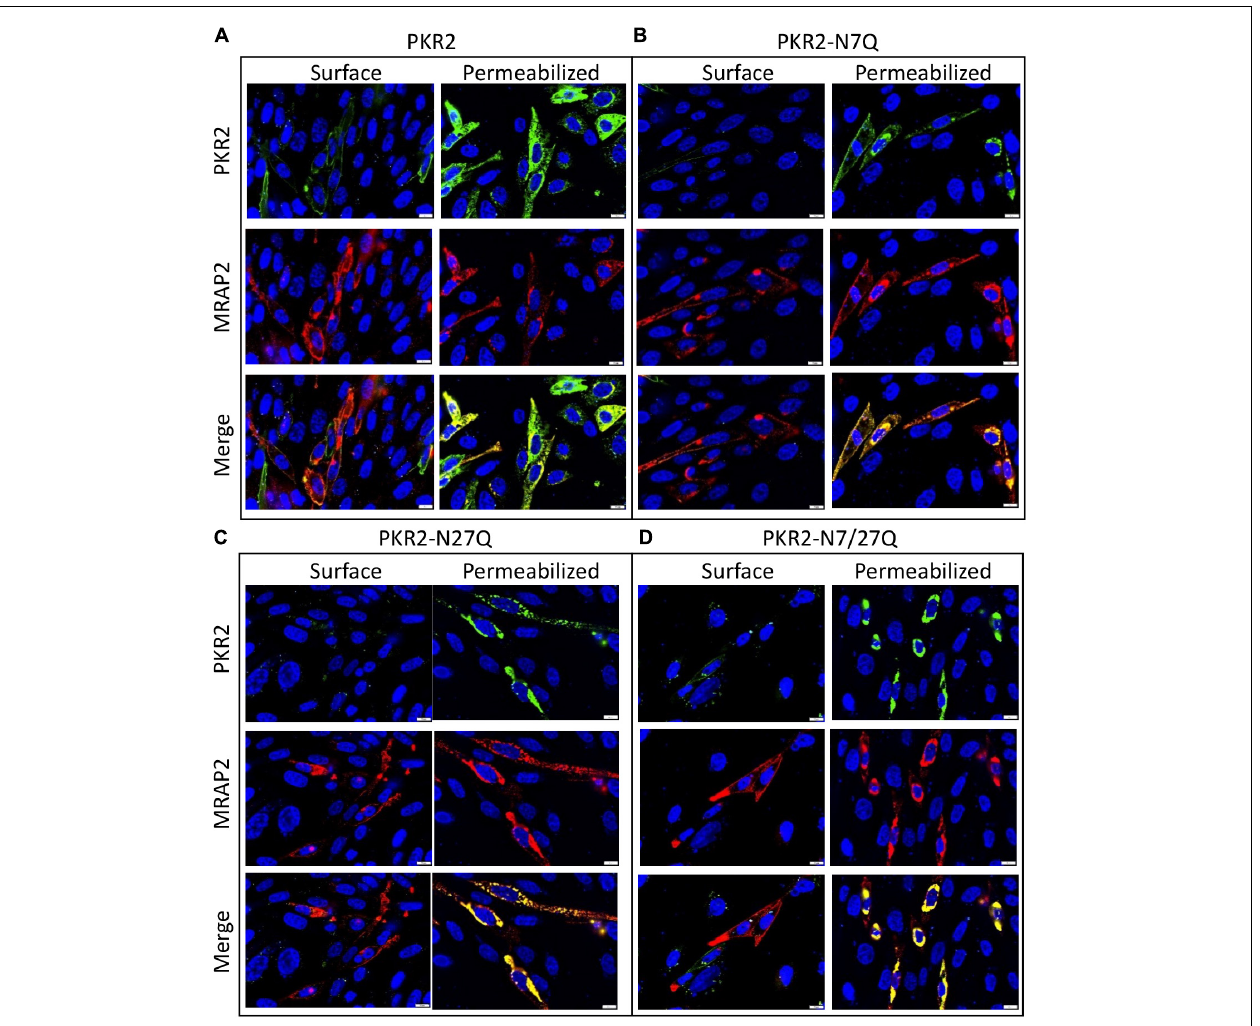
FIGURE 2 | Localization of PKR2 and glycosylation mutants PKR2 expressed with MRAP2. (A–D) Immunofluorescence detection of MRAP2 and 2HA-PK2 (A) , 2HA-PKR2-N7Q (B) , 2HA-PKR2-N27Q (C) , and 2HA-PKR2-N7/27Q (D) in non-permeabilized or permeabilized cells. PKR2 is shown in green, MRAP2 is shown in red and yellow depicts co-localization. Nuclei are shown in blue